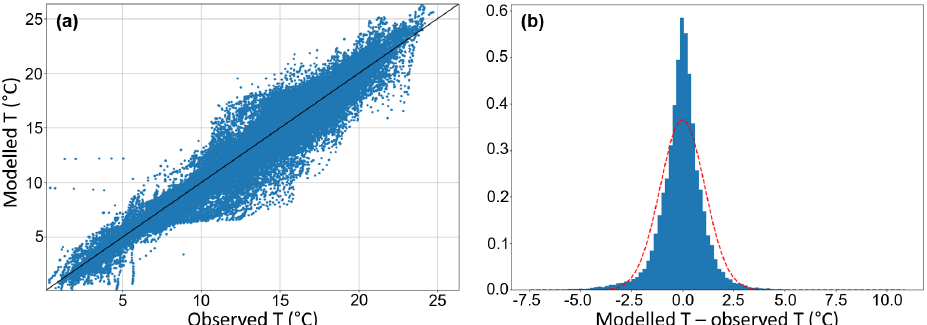
Figure 2. (a) Comparison between observed water temperature and simulated water temperature of Lake Erken in the interval 1961–2017 (correlation = 0.972) and (b) error distribution between modelled water temperature and observed water temperature (model–observation) retrieved from ACPy calibration (panel b ). RMSE = 1.089, MAE = 0.7529, bias =− 0 .